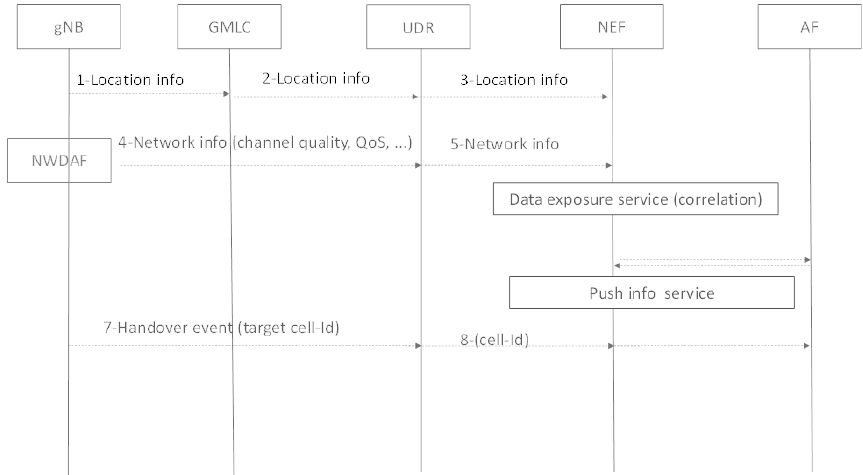
Figure 5. Impact over 3GPP interfaces and functional entities of aligning orchestration with data analytics and exposure framework.